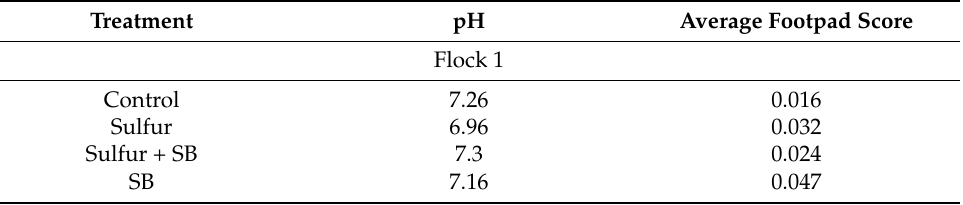
Table 4. Litter pH and average footpad score at day 38 in broilers treated with feed-through sulfur and sodium bisulfate litter